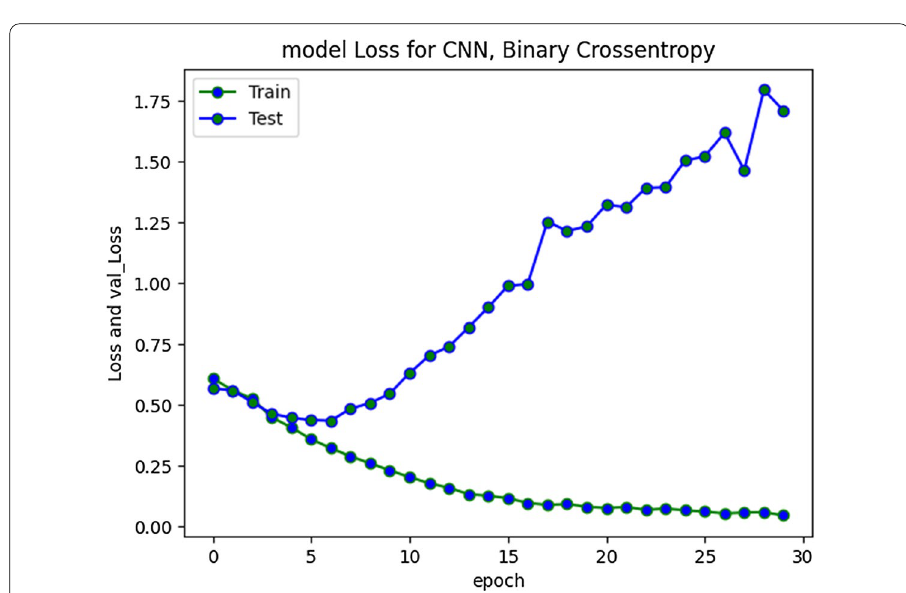
Fig. 17 CNN Model loss plot- Binary Cross entropy for 30